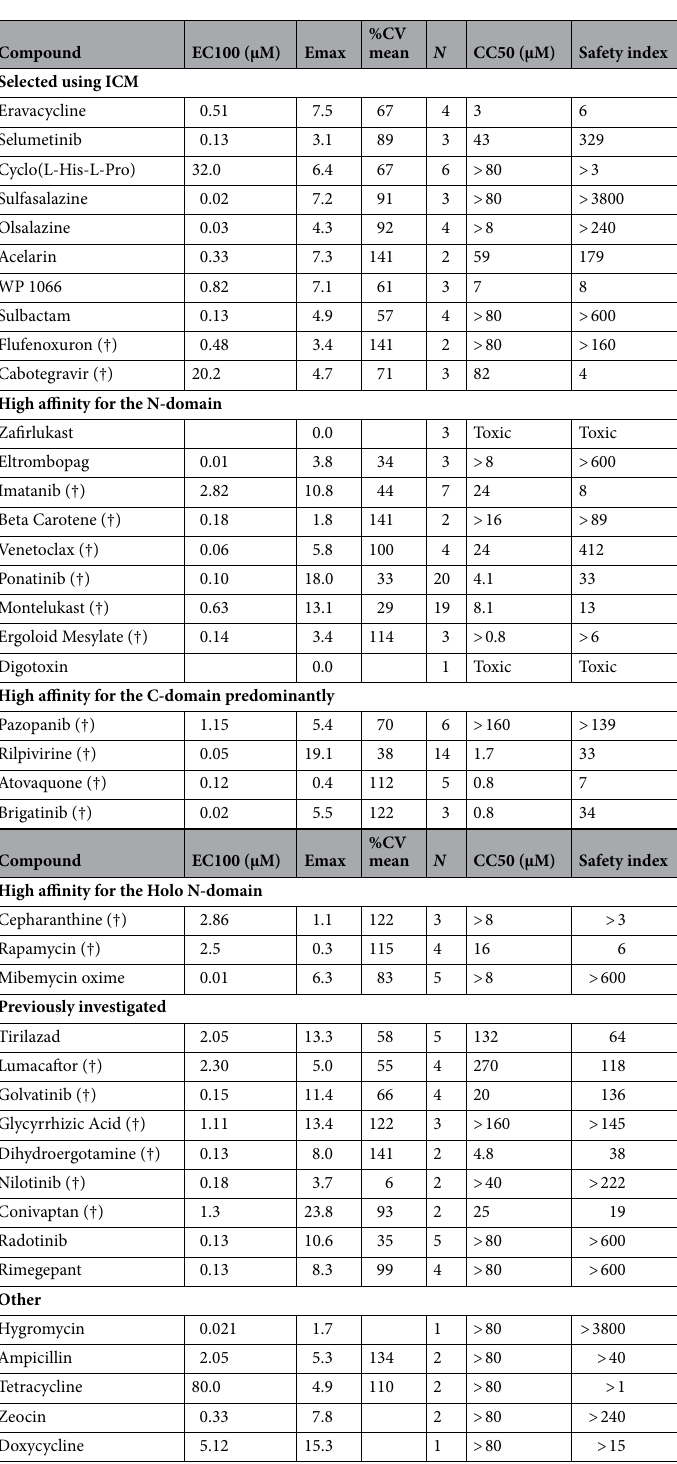
Table 2. Viability indices of selected compounds. Compounds were serially diluted in DMEM-N2 and applied to Nsp1-transfected H1299 cells in 96-well plates as described in “Methods” section. The maximum Efficacy (Emax) and concentration at which Emax was observed (EC100) were determined over N replicate experiments as indicated. The %CVmean is the ratio of standard error of the mean (SEM) to the mean and expressed as a percentage. The half-maximal cytotoxic concentration (CC50) of each compound was also determined using the Viability Index. The Safety Index is defined as the ratio of CC50 over EC100. Data for compounds determined under serum-free conditions (i.e. DMEM-N2) are marked (†), while all other data were determined in cells incubated with fetal calf